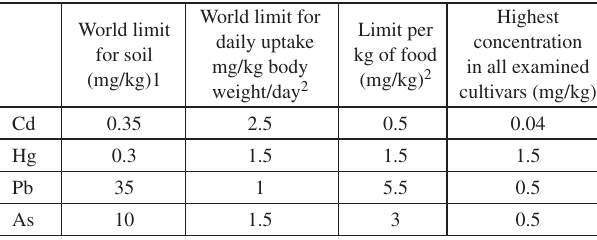
Table 2. World limit for soil contamination and daily uptake of trace elements in food and highest concentration of Hazardous elements in all examined apricots cultivars.